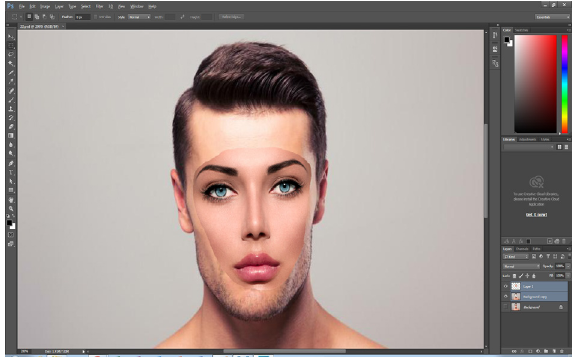
Figure 11. Confusion matrix for the SVC-based model